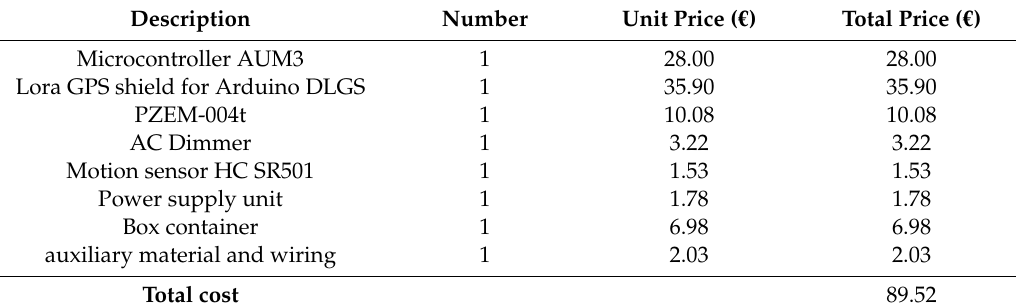
Table 4. MCDSL components